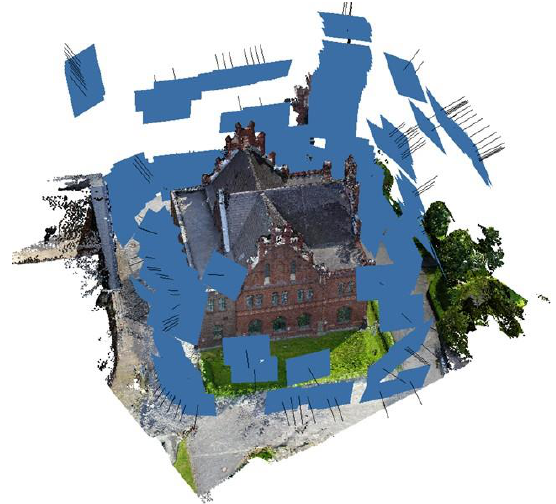
Figure 4. Image configuration for combined terrestrial and UAV